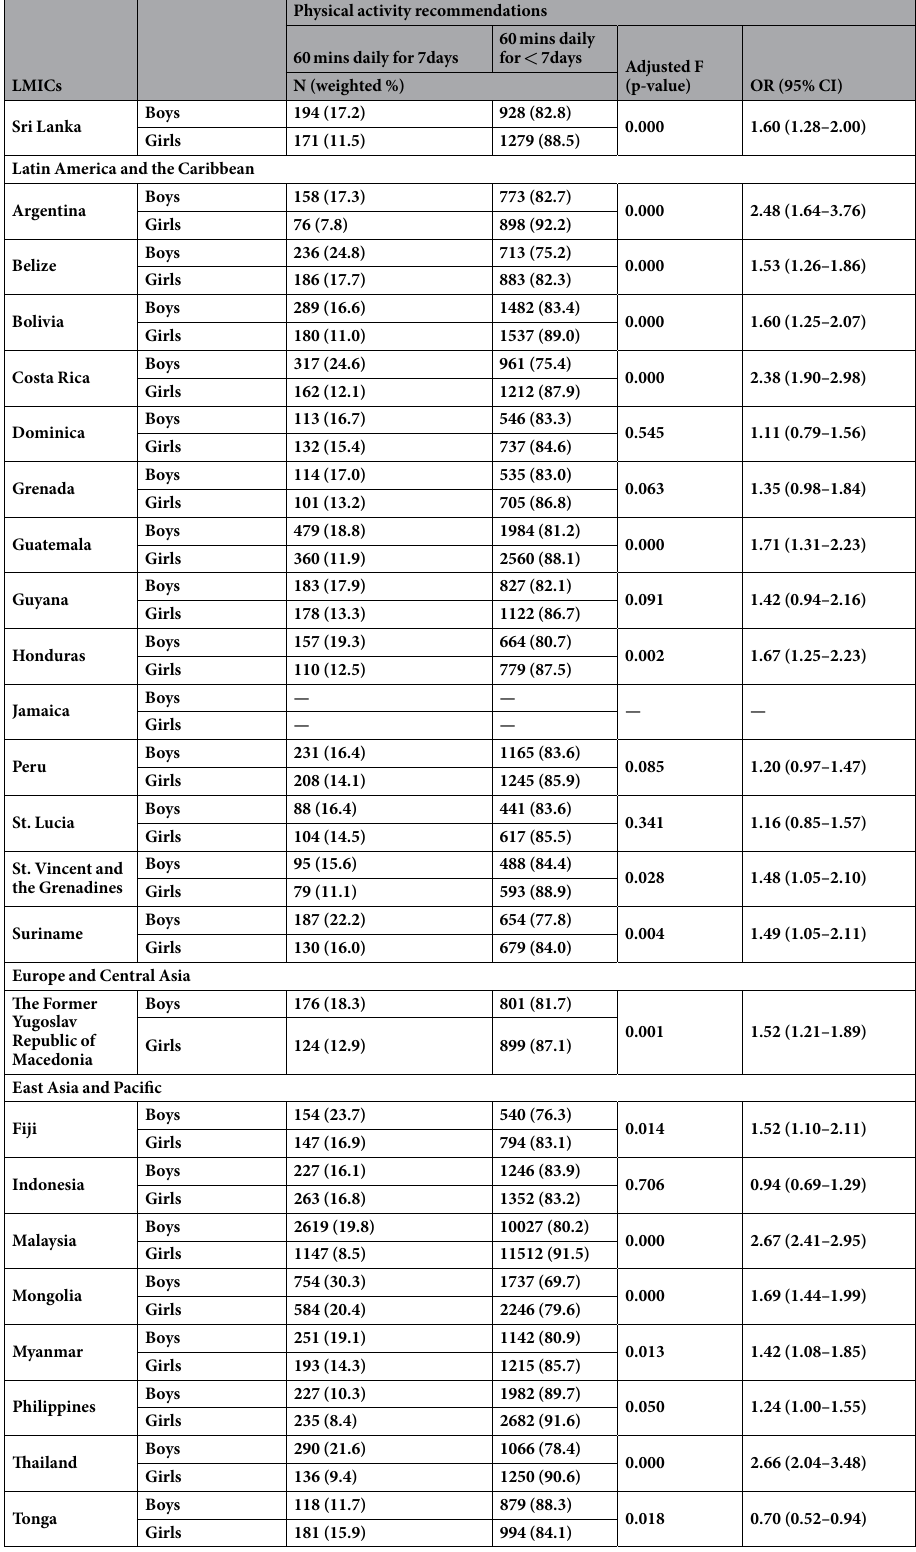
Table 3. Differences in the daily recommended physical activity behavior among adolescent girls and boys in Low-and Middle-Income Countries from the Global School-based Student Health Survey (2004–2013) (N = 163,123 adolescents from 49 LMICs). OR = Odds Ratio; CI = Confidence Interval; Boldface value are significant at P < 0.05; - no data